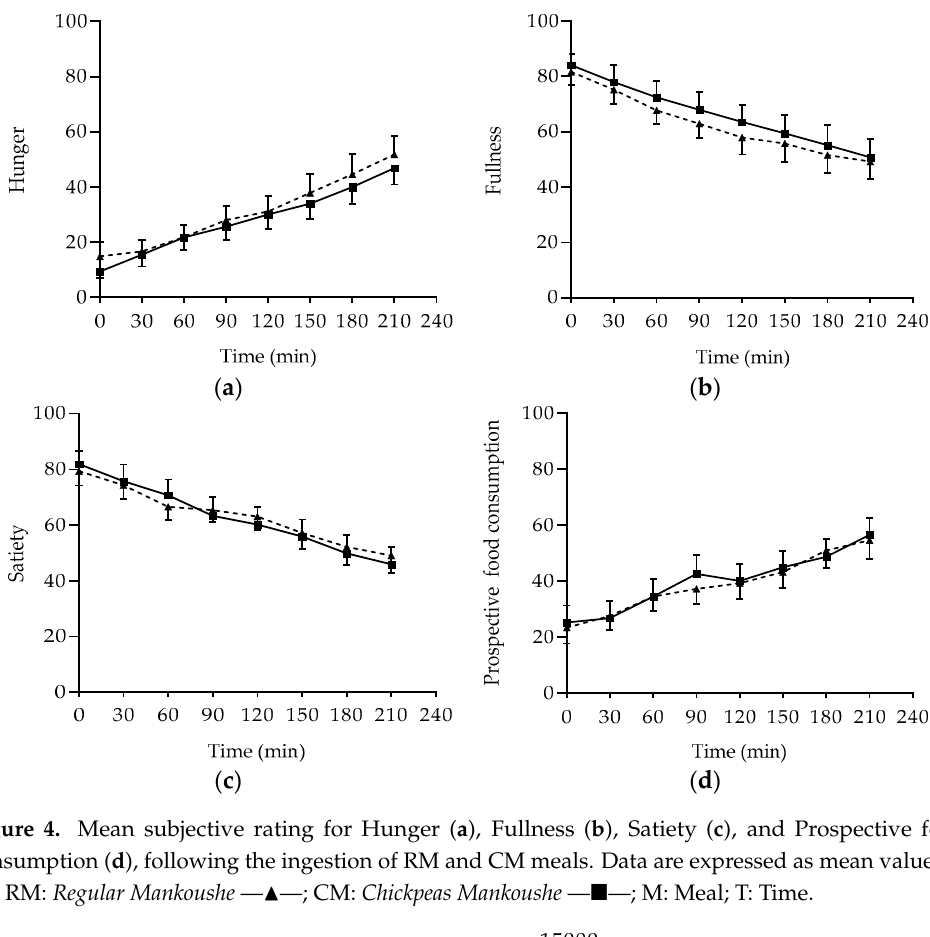
Figure 4. Mean subjective rating for Hunger ( a ), Fullness ( b ), Satiety ( c ), and Prospective food consumption ( d ), following the ingestion of RM and CM meals. Data are expressed as mean values ± SE. RM: Regular Mankoushe --- ---; CM: Chickpeas Mankoushe ― ― ; M: Meal; T: Time.